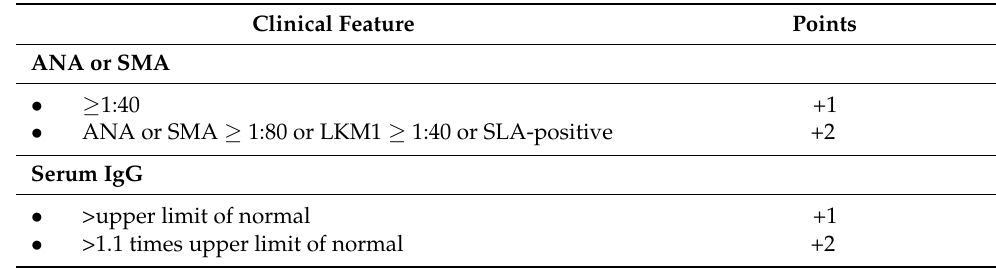
Table 1. Simplified Diagnostic Criteria for Autoimmune Hepatitis of International Autoimmune Hepatitis Group (IAHG)